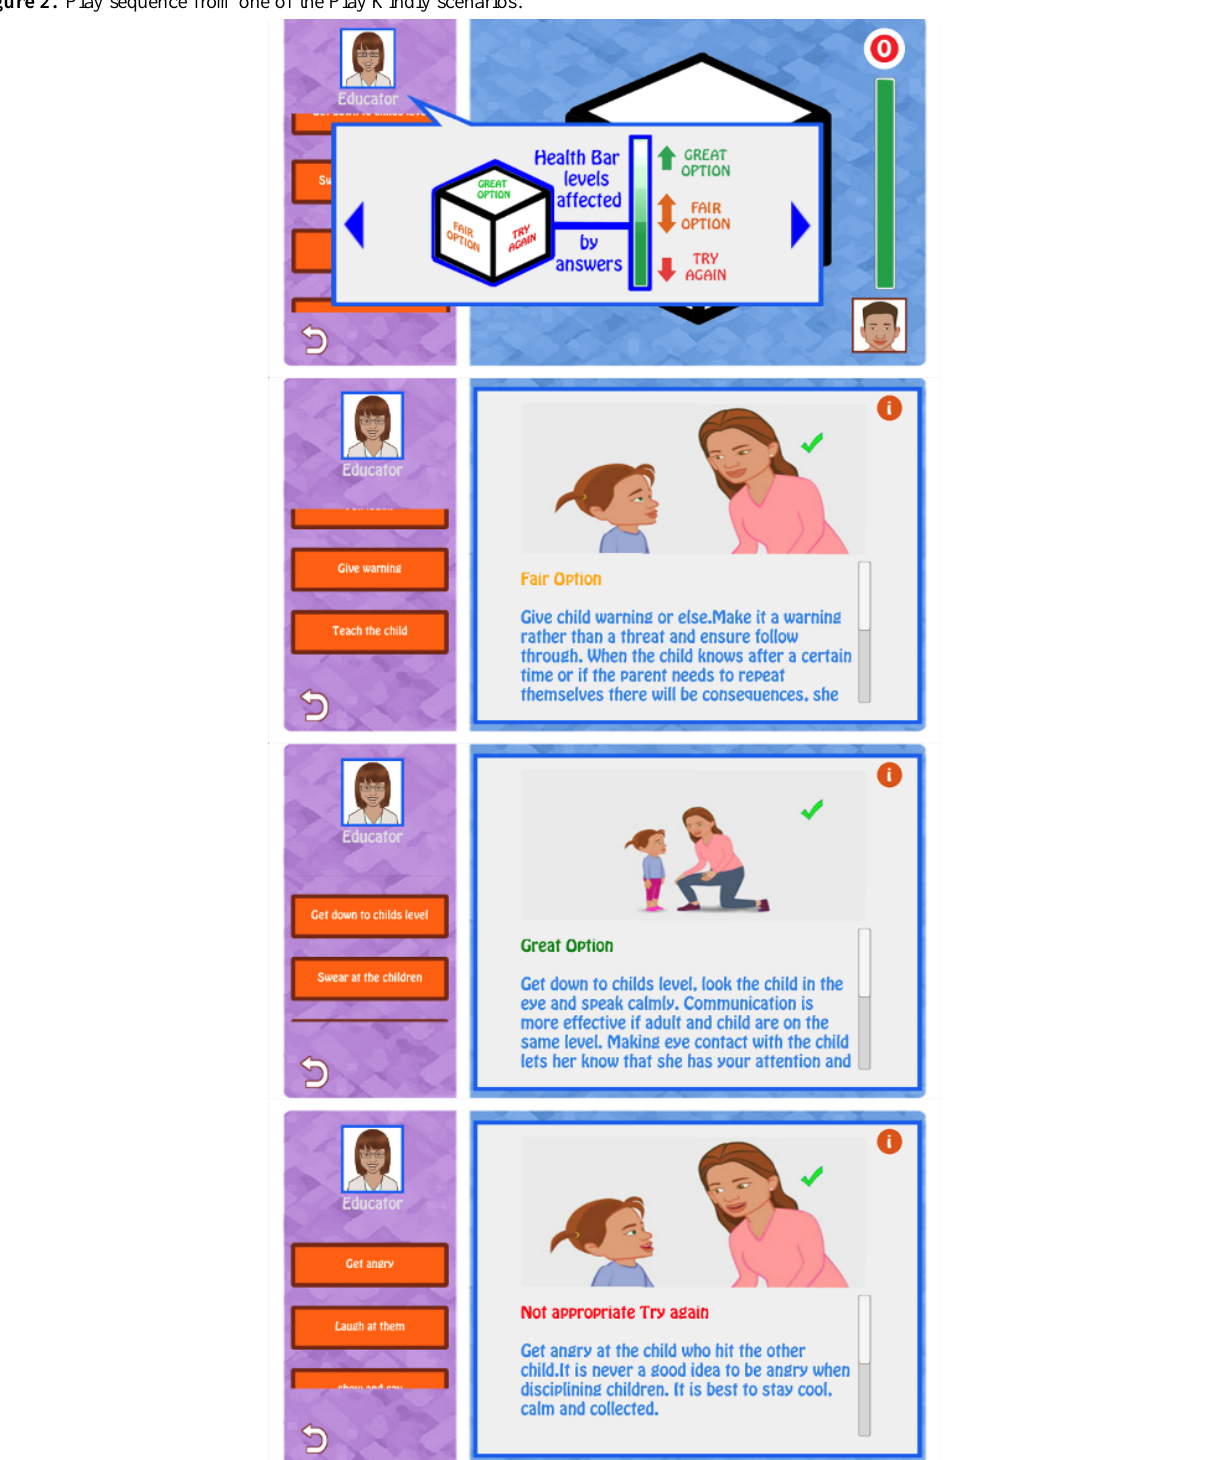
Figure 2. Play sequence from one of the Play Kindly